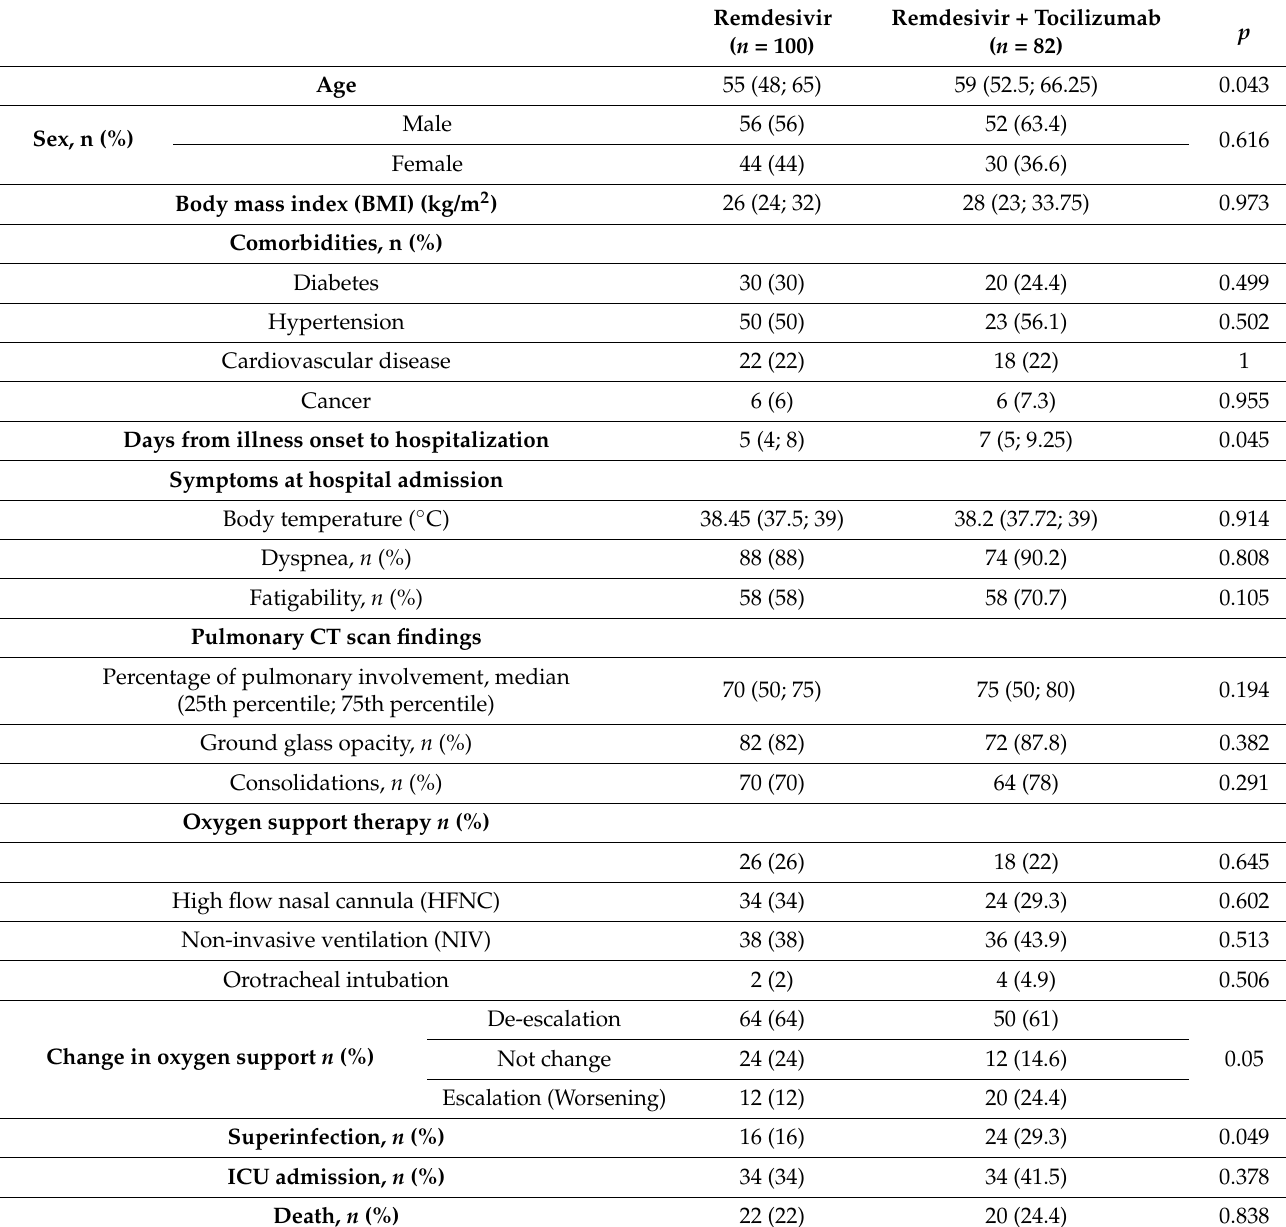
Table 1. Characteristics of the chosen